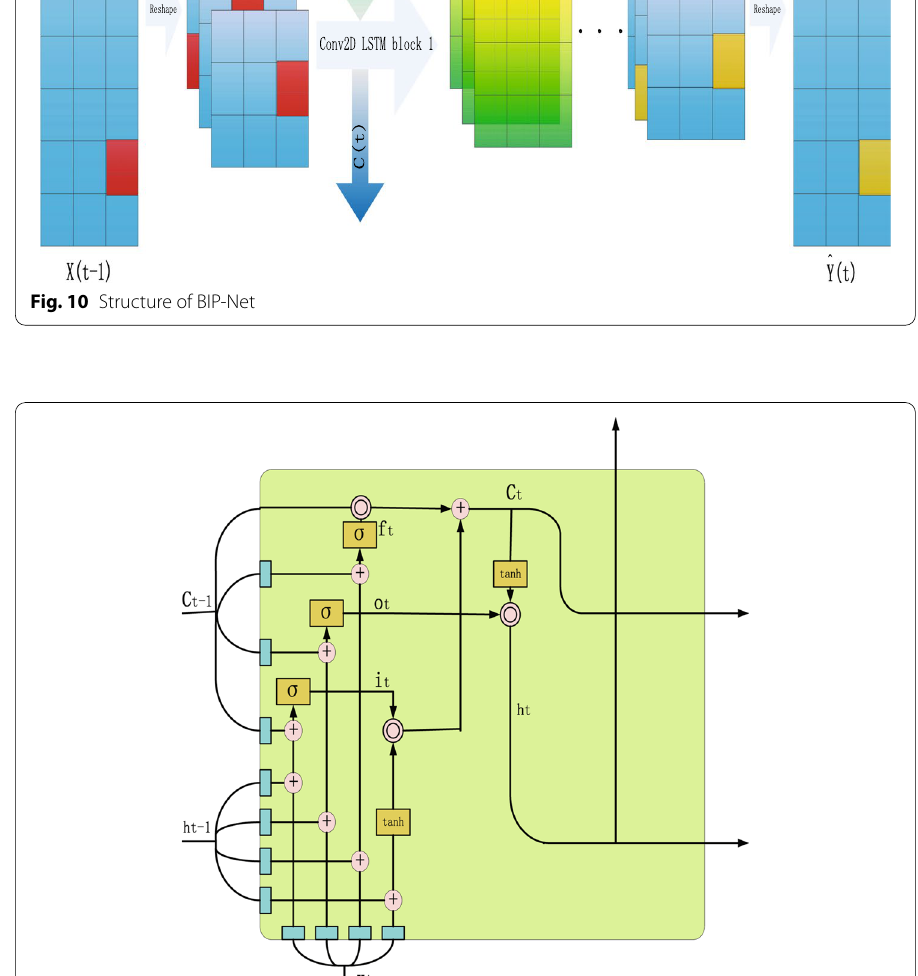
Fig. 11 Structure of Conv2D LSTM